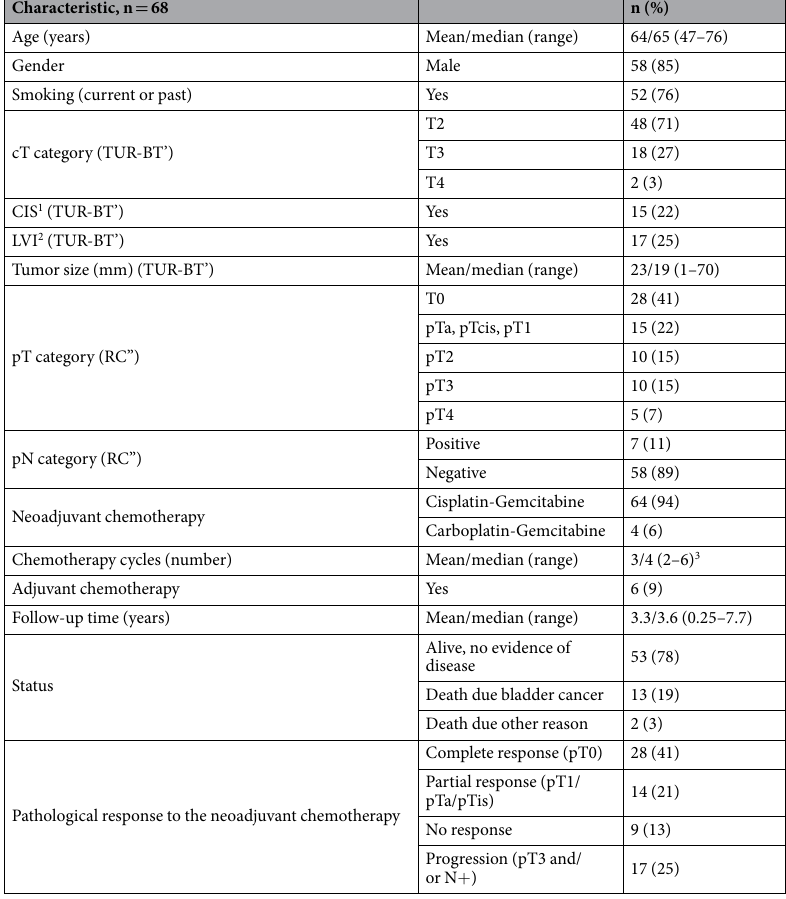
Table 1. Baseline clinicopathological characteristics, n = 68. ’According to the TUR-BT pathology, imaging studies and clinical status. ”According to the pathological data from RC. 1 Concomitant carcinoma in situ . 2 Lymphovascular invasion. 3 9 patients (13%) received 2 cycles of NAC, 23 patients (34%) 3 cycles, 34 patients (50%) 4 cycles, and 1 patient 6